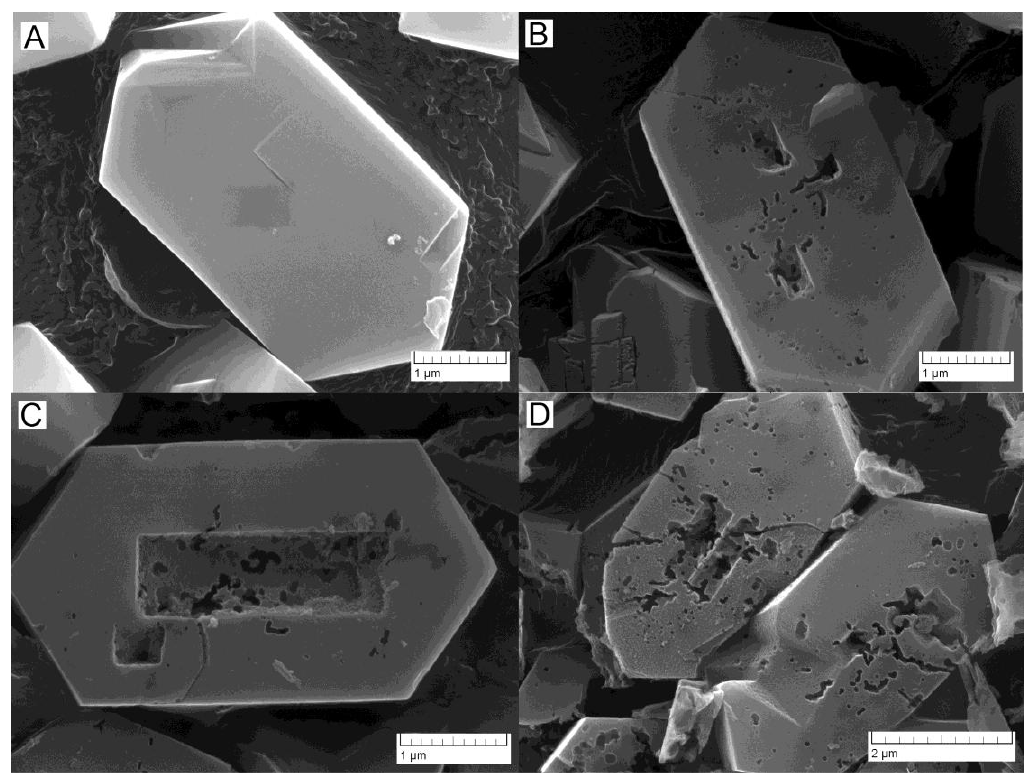
Figure 13. SEM images of ZSM-5 crystals treated by NH 4 F-HF solutions at 293 K. The NH 4 F-HF solutions contain different amounts of HF (0.05, 0.1, and 0.5 mol·L −1 ) and a constant amount of NH 4 F (2.5 g per 15 mL solution): ( A ) treated by a 0.05 mol·L −1 solution for 30 s; ( B ) treated by a 0.1 mol·L −1 solution for 30 s; ( C ) treated by a 0.5 mol·L −1 solution for 10 s; and ( D ) treated by a 0.5 mol·L −1 solution for 30 s [95]. Copyright American Chemical Society, 2013.